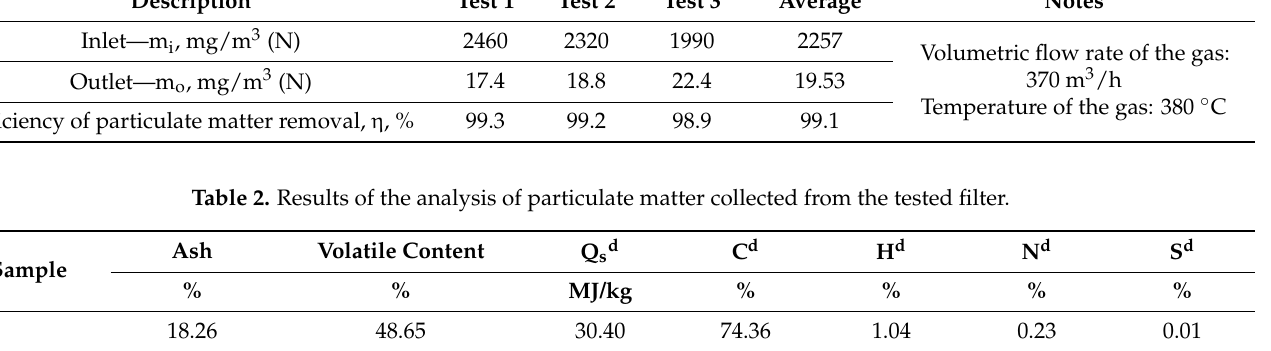
Table 3. Results of the measurements of particulate matter content in flue gas at the installation Table 1. Results of the measurements of the particulate matter content in the gas at the inlet and at the outlet of filter. Description